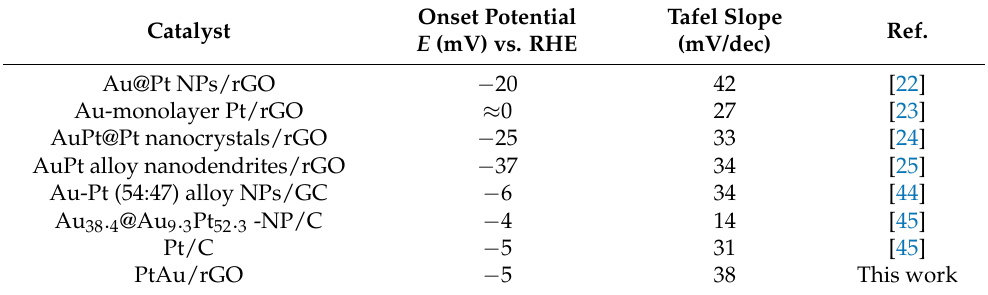
Table 4. Comparison of the activity of various PtAu catalysts for HER in 0.5 M H 2 SO 4 solution. Onset Potential Tafel Slope Catalyst E (mV) vs. RHE